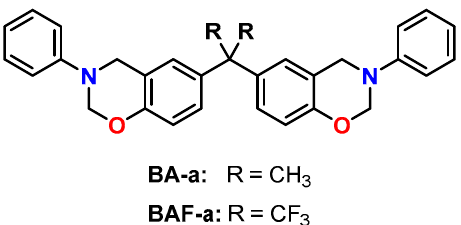
Figure 25. Chemical structures of the benzoxazine monomers BA-a and